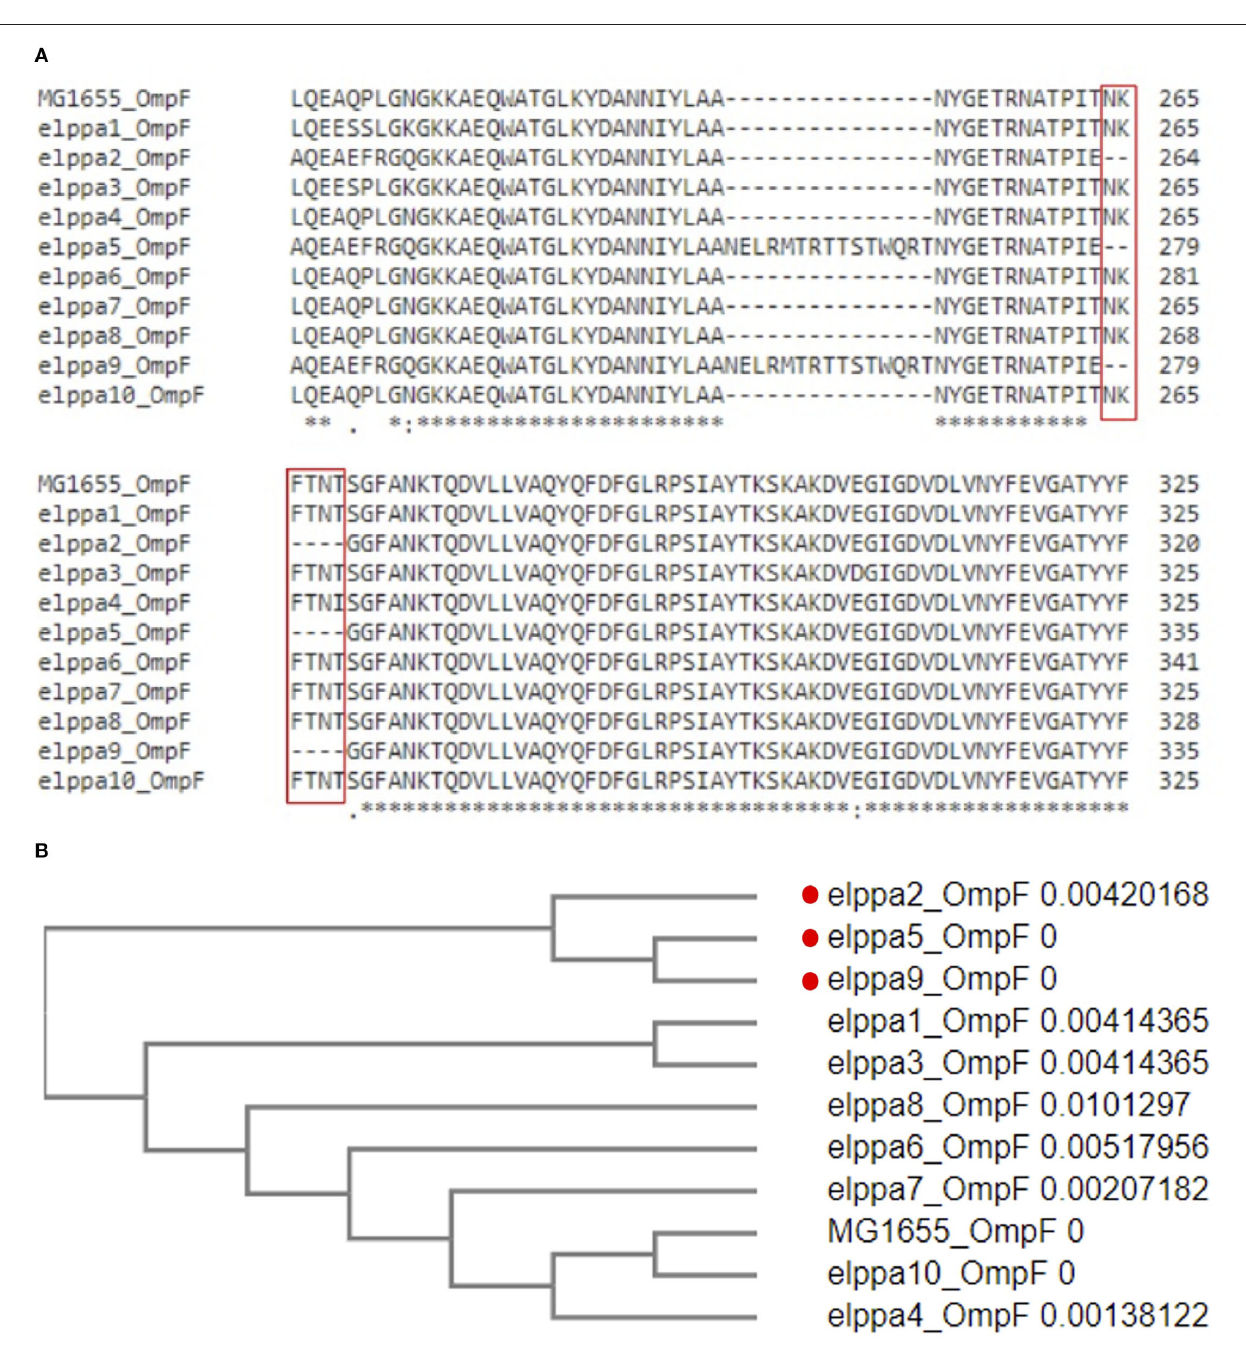
FIGURE 1 | (A) Multiple sequence alignment of OmpF revealed deletion in 264-269. (B) Phylogenetic clusters in deleted